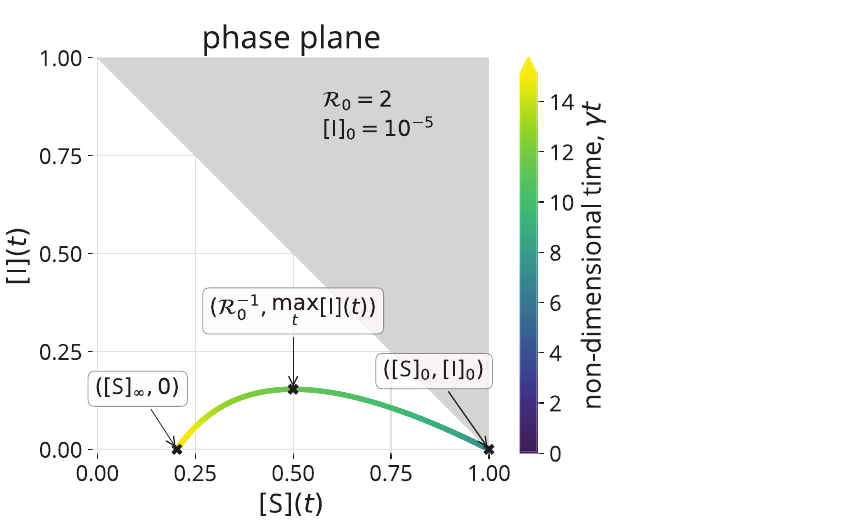
Figure 3 The trajectory of the solution to the SIR model, with initial conditions in Eqs. (6) – (8), in the ([S], [I]) phase plane, given by Eq. (10). The trajectory is colored according to time. The initial con- ditions, peak prevalence of infectious folks, and fi nal conditions are marked. Since [S]( t ) + [I]( t ) ≤ 1, points in the gray region are not